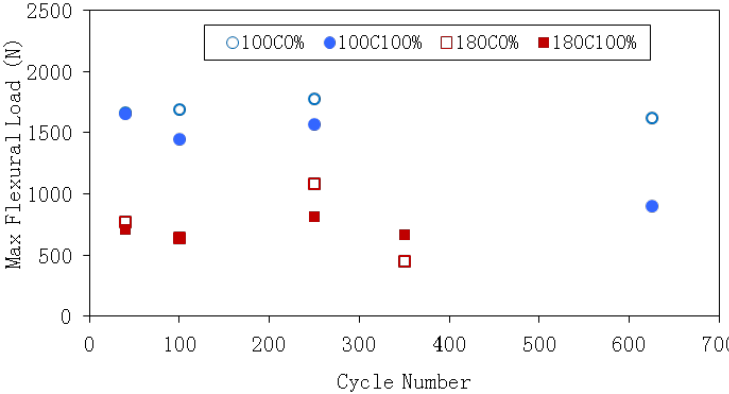
Figure 11. Max. flexural load vs. number of cycles at 100 °C and 180 °C (Cp = 2, 0% and 100% humidity).